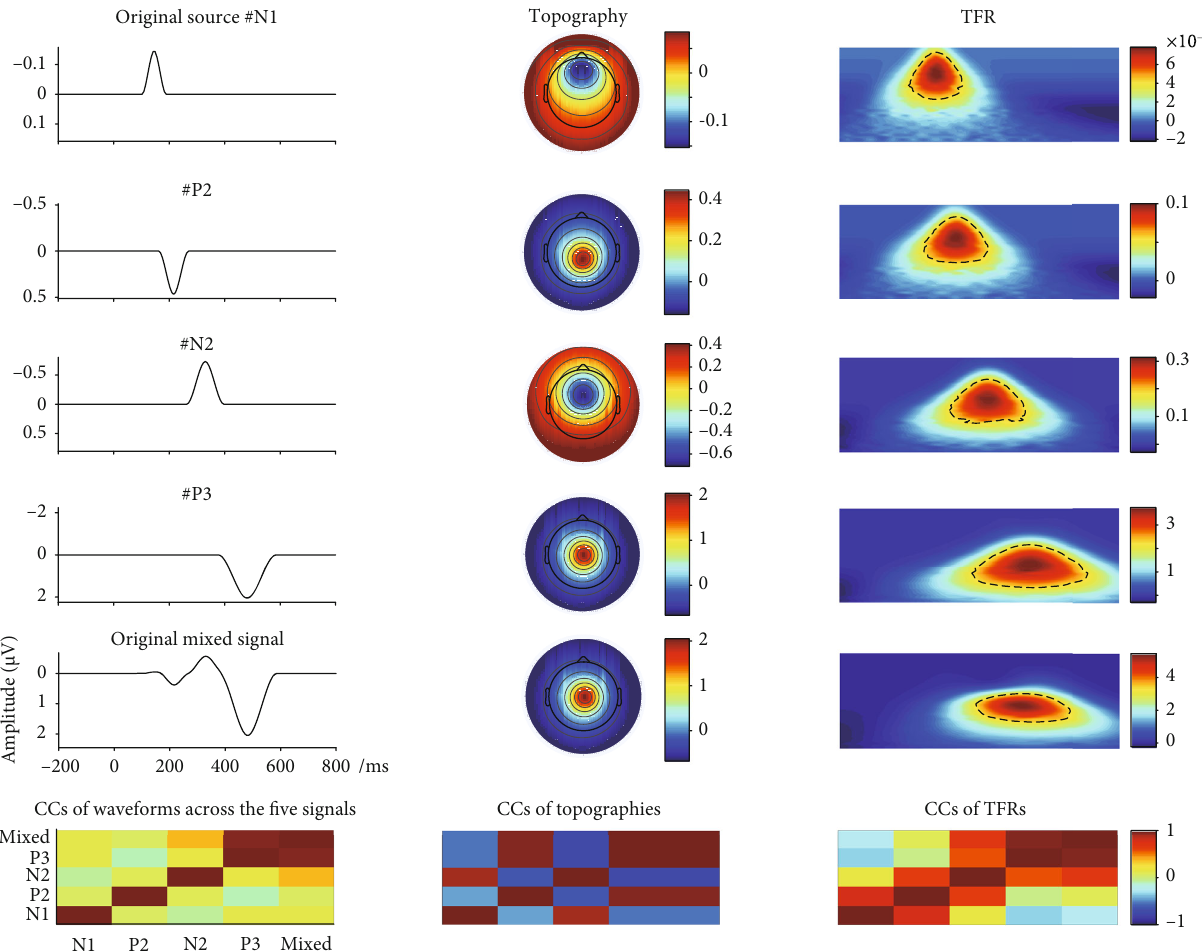
Figure 2: The waveforms, associated topographies, and time-frequency representations (TFRs) for single source N1 (Fz), P2 (CPz), N2 (FCz), P3 (Cz), and mixed signal (Cz), respectively (the fi rst fi ve rows). The last row represents the correlation coe ffi cients (CCs) of waveforms/topographies/TFRs among all fi ve signals. The 65 sets of simulation signals were generated from these sources based on setting the variations of amplitude and latency for